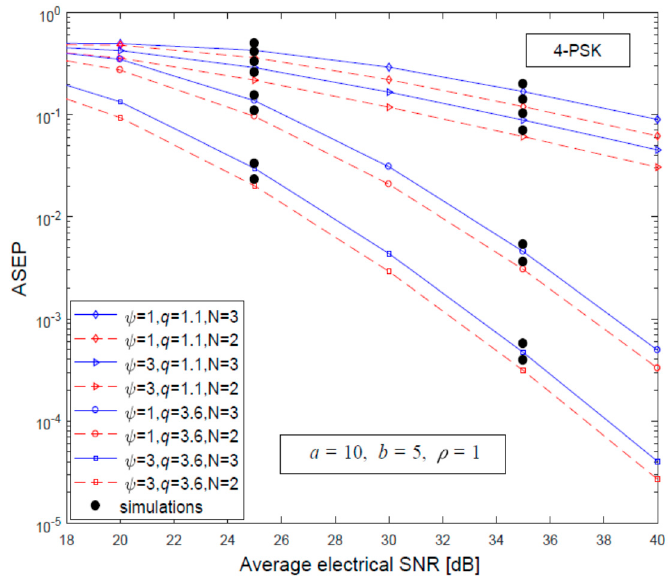
Figure 2. ASEP versus average electrical SNR of multi-hop FSO configurations for weak turbulence strengths, weak and strong amounts of non-zero boresight pointing errors, and 4-PSK modulation formats with moderate and strong phase noise impairments.